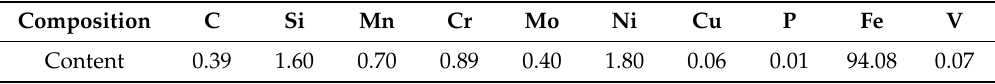
Table 1. Chemical composition of the hot-rolled 300M steel (wt.